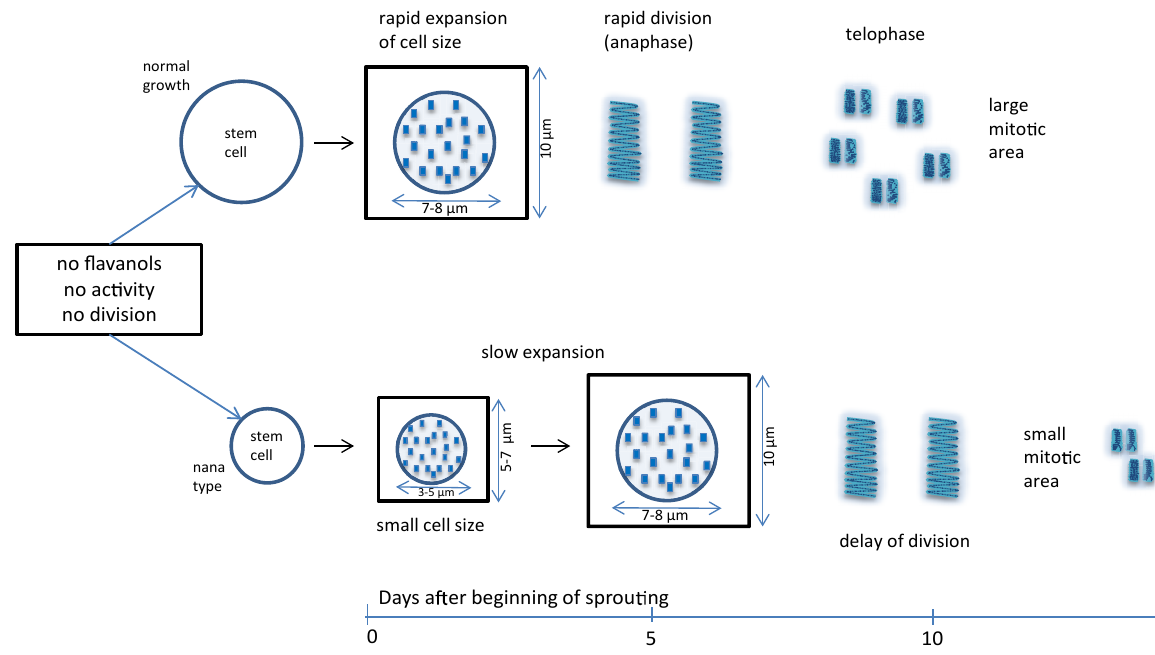
Figure 1. The beginning of sprouting in the normal and the Tsuga canadensis nana types; the dwarf type has smaller stem cells and a major group of the descendant cells, including the nuclei, is reduced in size; both cell expansion and cell division are delayed; in the end, mitotic areas are smaller. Stem cell nuclei have no